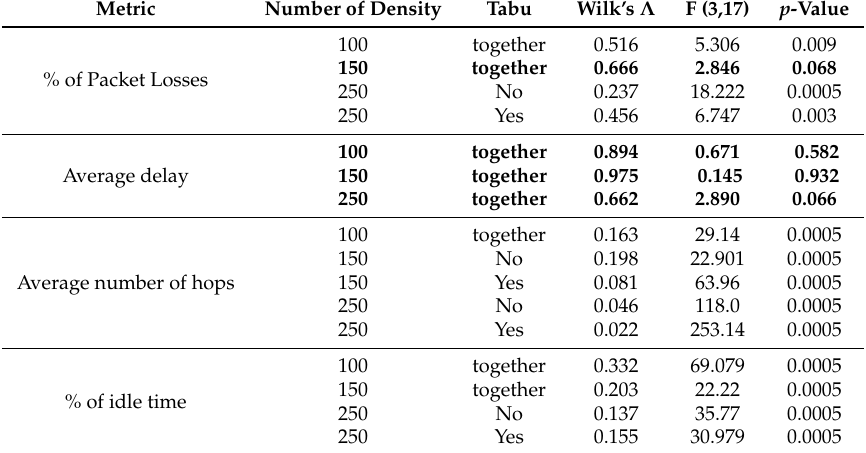
Table 3. MANOVA [37] results of the testing difference in performance metrics among routing forwarding techniques ( FT ). There is a significant difference when the p -value < 0.05. “Together” means that to apply the test, it is not needed to differentiate the use of Tabu in the forwarding techniques.